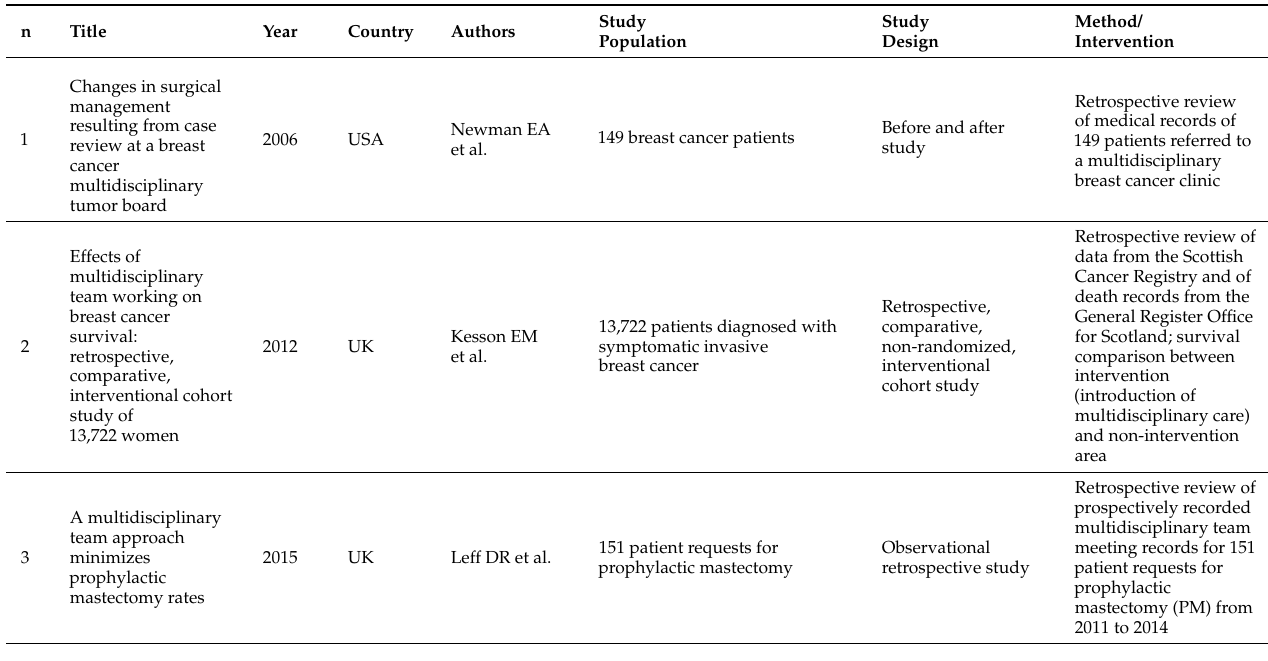
Table 1. Characteristics of the included